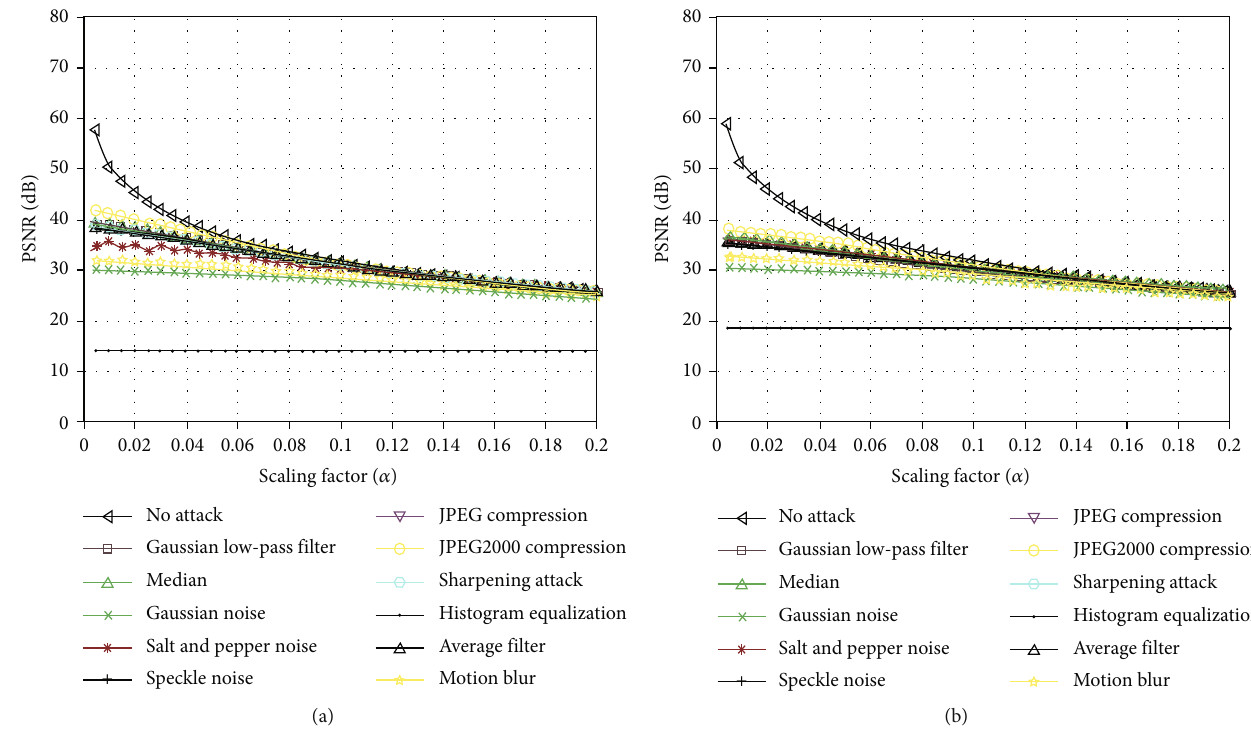
Figure 6: PSNR scaling factors: (a) lion image and (b) Elaine